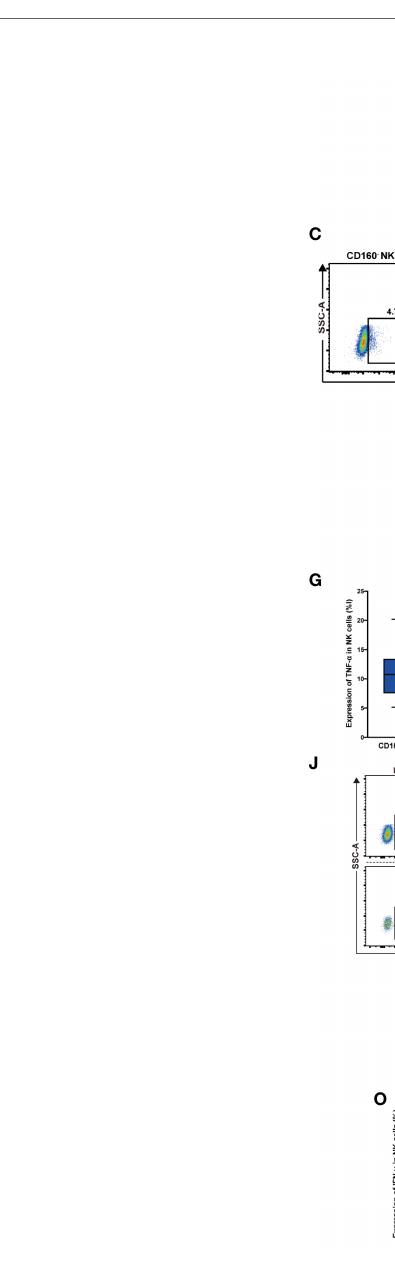
FIGURE 2 | Expression of CD160 enhances NK cell effector function and activating CD160 improves IFN- g production. (A, B) Comparison the expression of CD69, the NK cell activation marker, between CD160 - and CD160 + NK cells in HIV-infected individuals (n = 17). PBMCs from HIV-infected individuals were stimulated with IL-12 + IL-15 + IL-18 (10, 50 and 100 ng/ml, respectively) for 24 h to detect the following NK cell functions (C – N) . (C) Ki67 expression in CD160 - and CD160 + NK cells measured by fl ow cytometry. Plots are representative of data from HIV-infected individuals. (D, E) Paired comparisons of percentage (D) and MFI of Ki67 expression (E) between CD160 – and CD160 + NK cells in HIV-infected individuals (n = 19). (F) Correlation between the MFI value of CD160 and Ki67 expression in total NK cells from HIV-infected individuals (n = 19). (G, H) Percentages (G) and MFI of TNF- a (H) expression in CD160 - and CD160 + NK cells from HIV-infected individuals (n = 28). (I) Correlation between the MFI of CD160 expression and TNF- a production in total NK cells from HIV-infected individuals (n = 28). (J) Representative cytometry dot plots showing percentages of IFN- g -producing CD160 - and CD160 + NK cells in HIV-infected individuals. (K, L) Paired comparison of the percentages (K) or MFI (L) of IFN- g production between CD160 - and CD160 + NK cells in HIV-infected individuals (n = 16). (M, N) Correlation between the MFI (M) or percentage (N) of CD160 expression on total NK cells and the MFI of IFN- g expression in total NK cells (n = 16). (O, P) PBMCs were treated with 10 μg/ml CL1-R2 antibody (anti- CD160 agonistic mAb) or negative control IgG1 for 1h and then stimulated with IL-12 + IL-15 + IL-18 (10, 50 and 100 ng/ml, respectively) for 24 h, then percentages (O) , MFI (P) of IFN- g production in total NK cells from HIV-infected individuals were analyzed (n = 16). The mean fl uorescence intensity of CD69, Ki67, TNF- a , and IFN- g in (B, E, H, L) was from CD160 - and CD160 + NK cells, respectively. And the mean fl uorescence intensity of CD160, Ki67, TNF- a , and IFN- g in (F, I, M, N, P) was from total NK cells. A Wilcoxon matched-pairs signed-rank test was employed for paired-group comparisons. A Spearman ’ s rank test was applied for correlation analysis; * P < 0.05; ** P < 0.01; *** P < 0.001; **** P < 0.0001. Data are represented as means ±